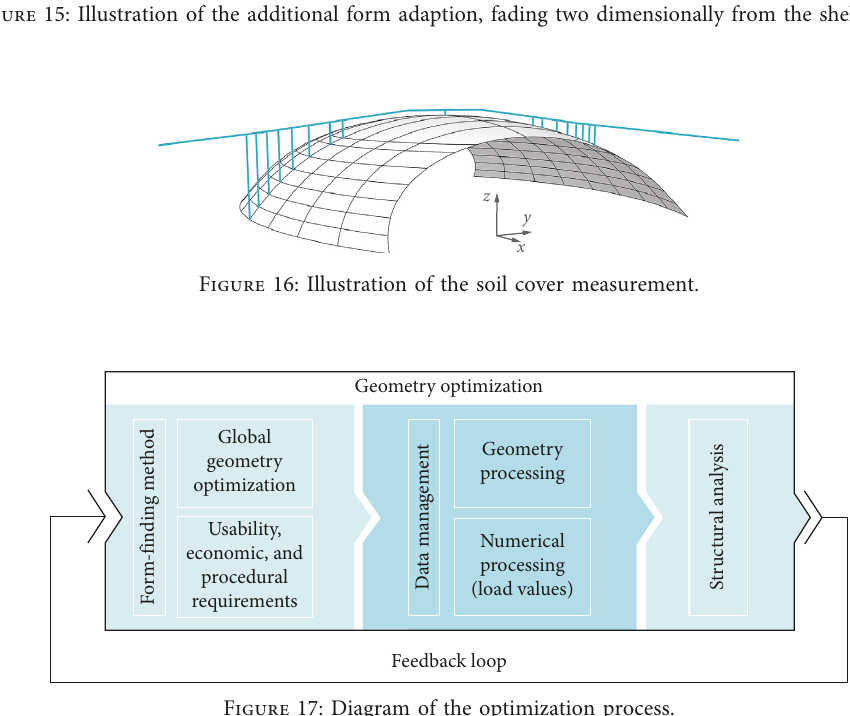
Figure 17: Diagram of the optimization process.